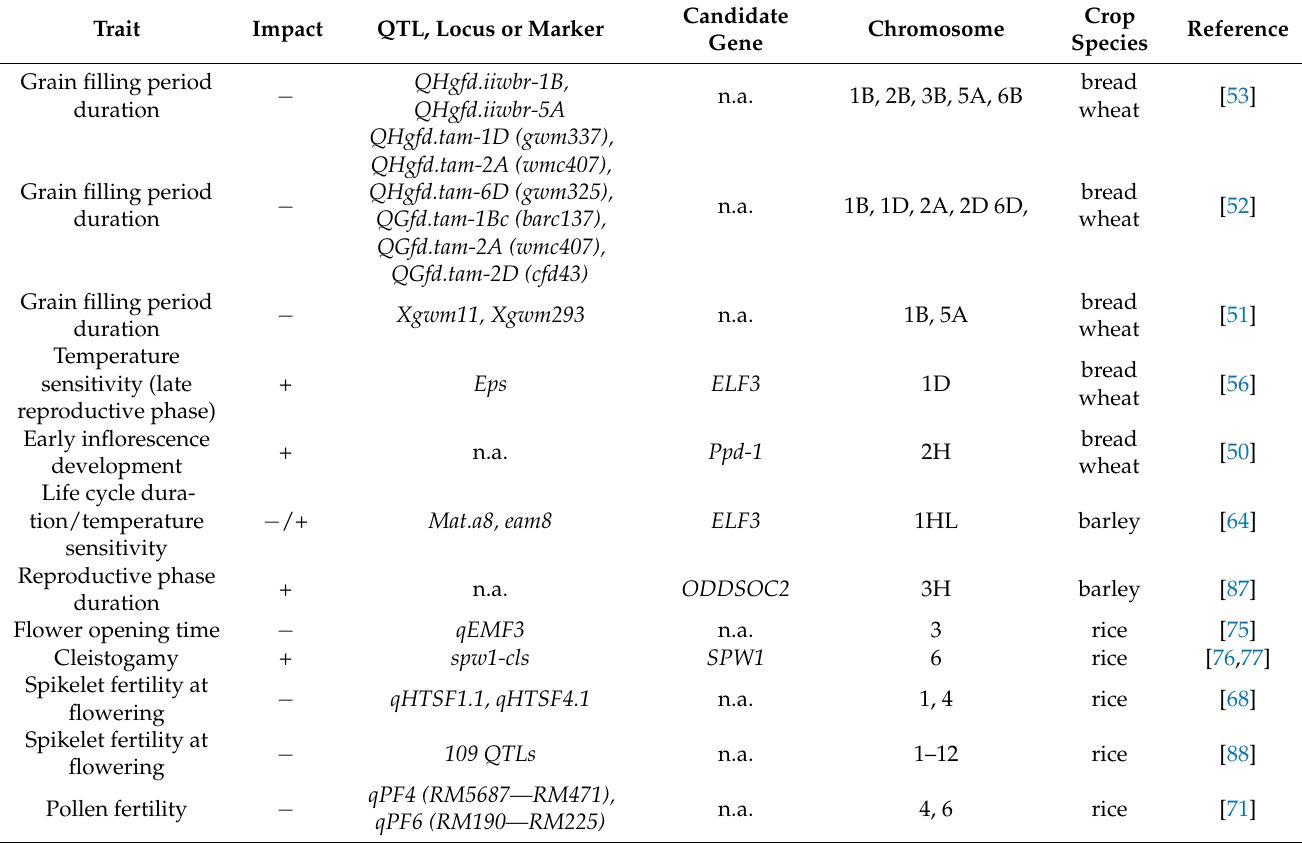
Table 3. Effects of high temperatures on cereal crop development and reproduction. The ‘+’ sign indicates an increase, and the ‘ − ’ sign shows a decrease in the performance of the trait of interest. n.a.: not